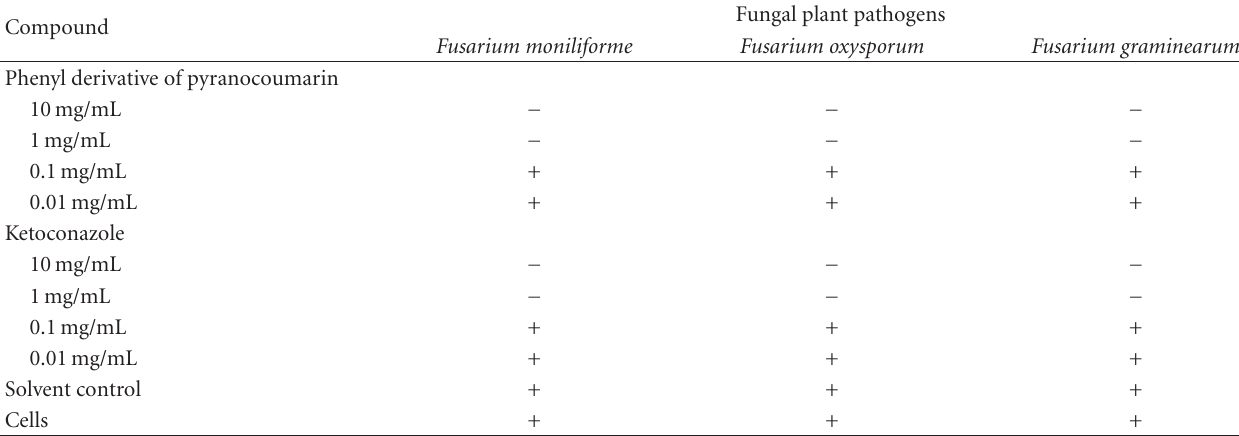
Table 3: Minimum inhibitory concentration of PDP against fungal plant pathogens.